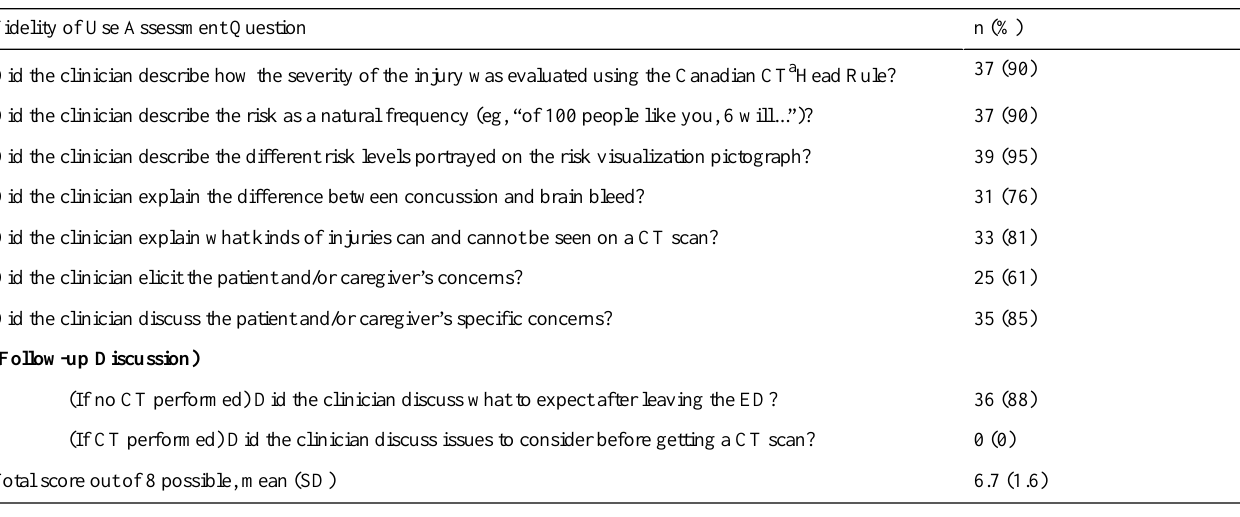
Table 5. Fidelity score and compliance with delivery of the intervention as